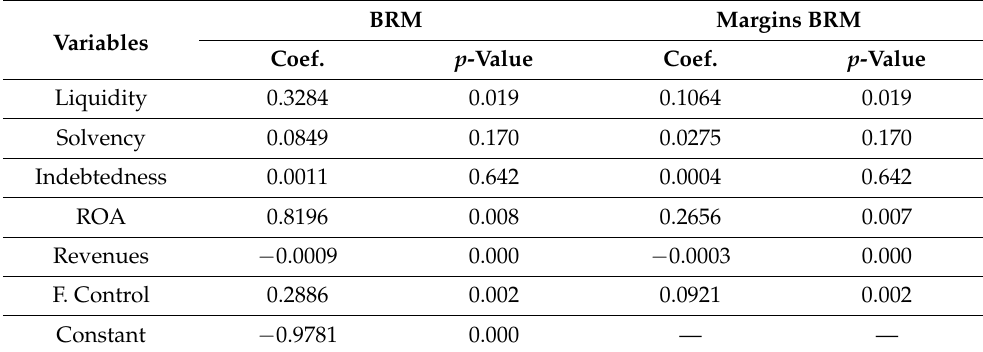
Table 5. Estimations of Equation (2). Dependent variable H-index. BRM Margins BRM Variables Coef. p -Value